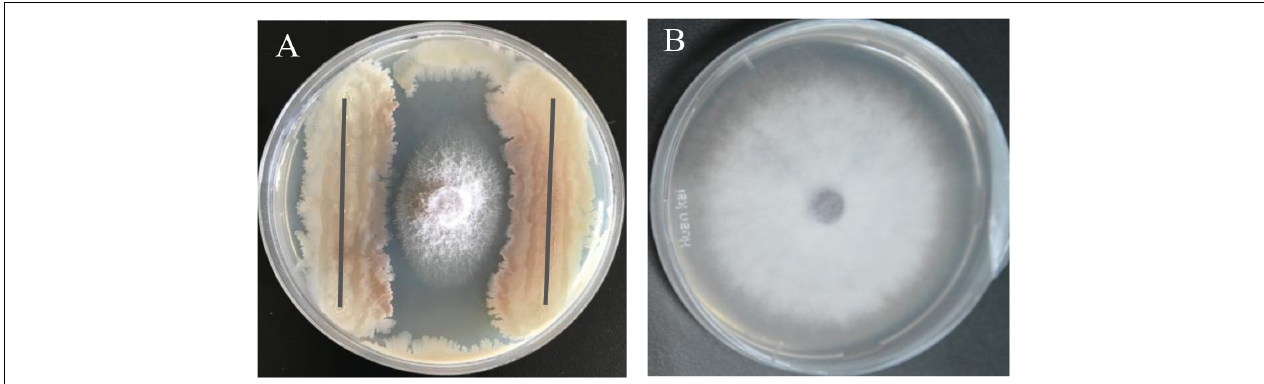
FIGURE 2 | Antagonism of B. amyloliquefaciens B2 against plant pathogen F. oxysporum f. sp. cucumerinum (FOC). (A) Antagonistic effects of strain B2 against FOC. (B) FOC grown on potato dextrose agar (PDA) plate as